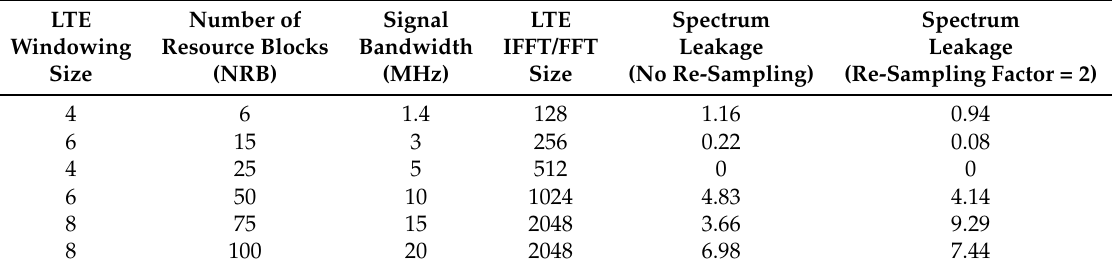
Table 5. LTE Signal structure